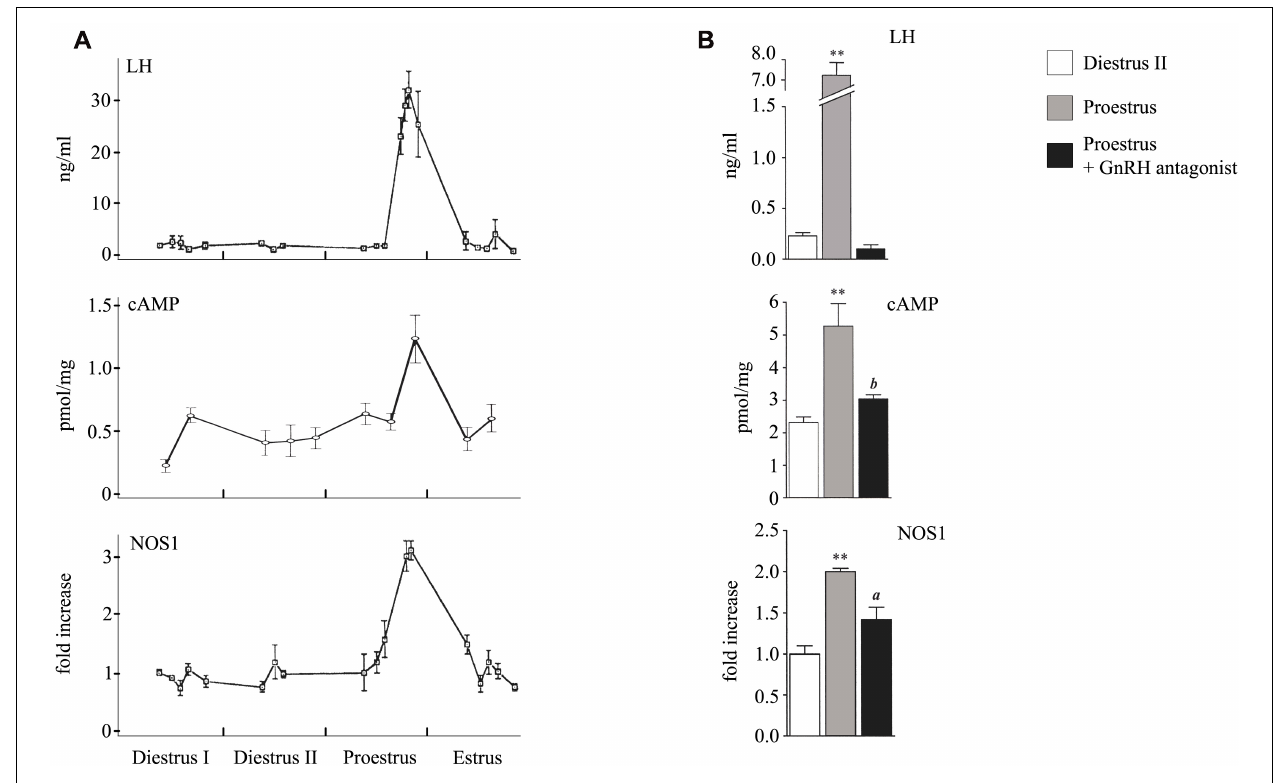
FIGURE 1 | Profiles of serum LH and pituitary cAMP and NOS1 levels during the proestrus and following administration of a GnRH antagonist. (A) Serum LH, pituitary cAMP, and pituitary NOS1 levels were determined by radioimmunoassay, ELISA, and western blot analysis, respectively.